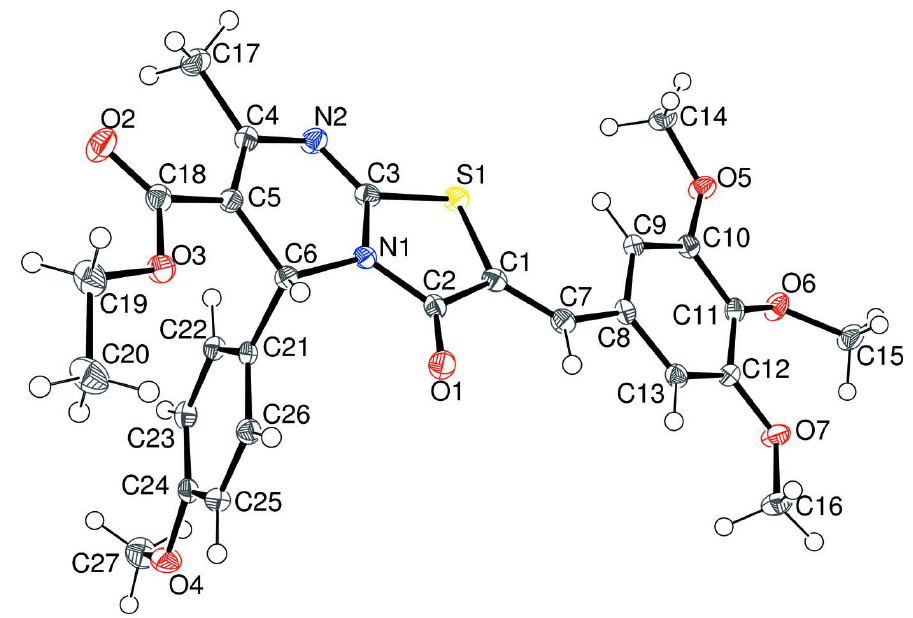
The molecular structure of (I), drawn with 50% probability ellipsoids (arbitrary spheres for the H atoms). (2 Z )-Ethyl 5-(4-methoxyphenyl)-7-methyl-3-oxo-2-(3,4,5-trimethoxybenzylidene)-3,5- dihydro-2 H